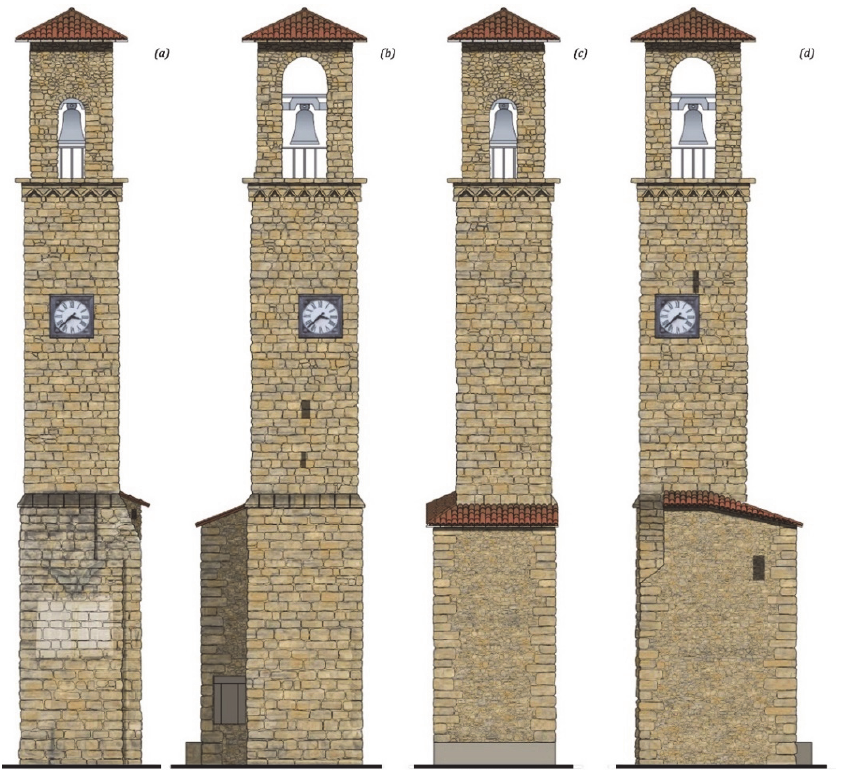
Figure 5: Survey of stones' texture of the North façade (a), East façade (b), South façade (c), West façade (d) of the civic clock tower of Amatrice in the Province of Rieti